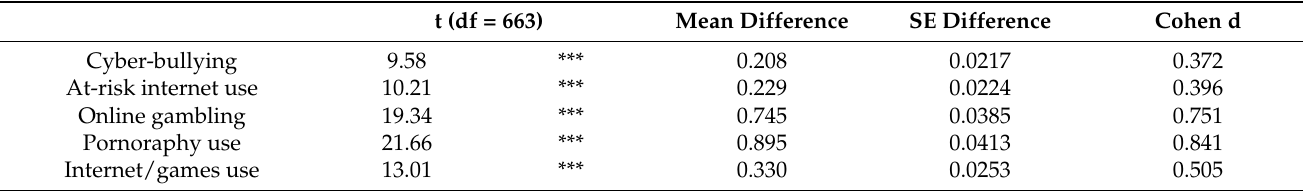
Table 2. Within-subject between-grade (primary versus secondary school) differences in the perceived importance of conducting prevention interventions focused on screen-related risks during the fall 2020 wave of long-term distant schooling caused by COVID-19 (n =